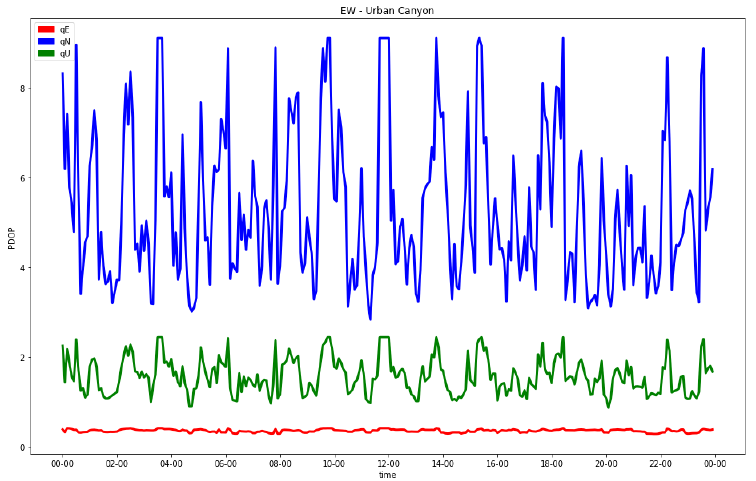
Figure 9. Diagonal coefficients in N (blue), E (red) and U (green) coordinates of final co-factor matrix in EW street (C5N5-CG-TDoA) for urban